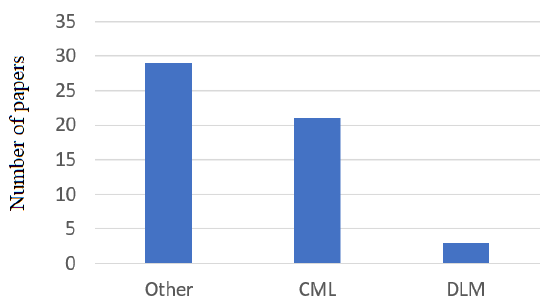
Figure 7. Distribution of computational models used in head motion recognition.